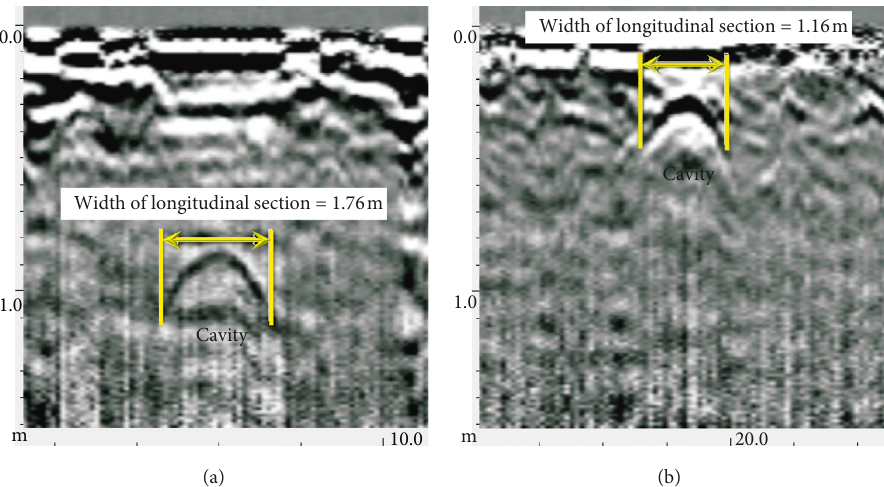
Figure 6: Measurement example of scale (soil depth and width) by the cavity waveforms. (a) Depth: 0.9 m and width:1.0m. (b) Depth: 0.3m and width: 0.5m.